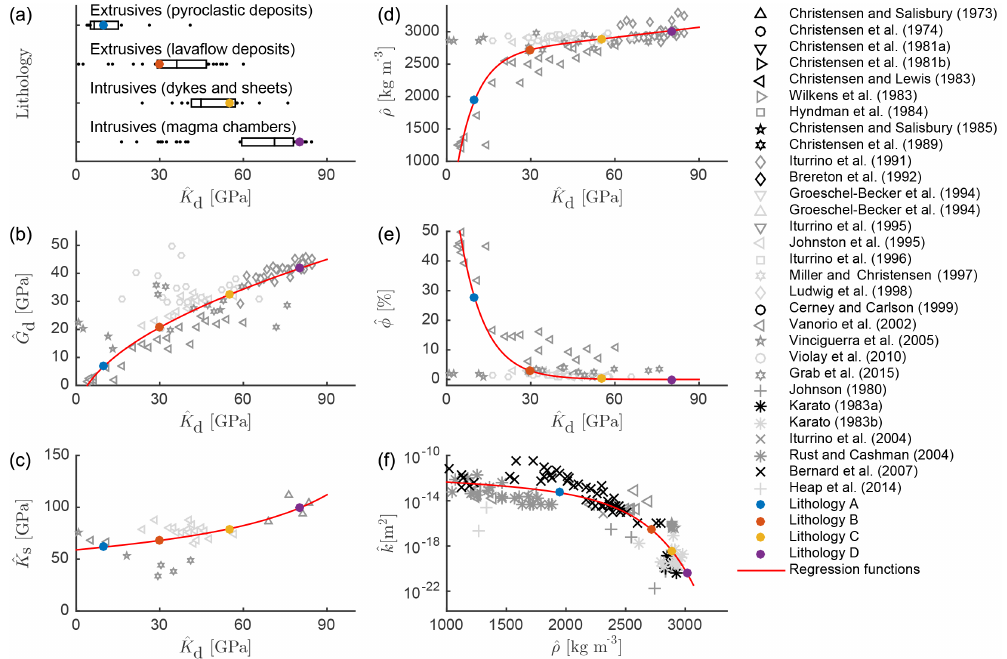
Figure 4. Lithological classification (a) , physical properties (b–e) of dry rocks versus dry frame bulk modulus, and hydraulic permeability versus bulk density (f) , as reported in the literature for low confining pressures. Bulk moduli distributions for the lithologies are given as boxes indicating the 25th and 75th percentiles with outliers indicated by the dots. Red lines are best-fit functions obtained from regression analysis, using dry samples only. Bold blue, orange, yellow and purple dots are the values used to parameterize models for lithologies A, B, C, and